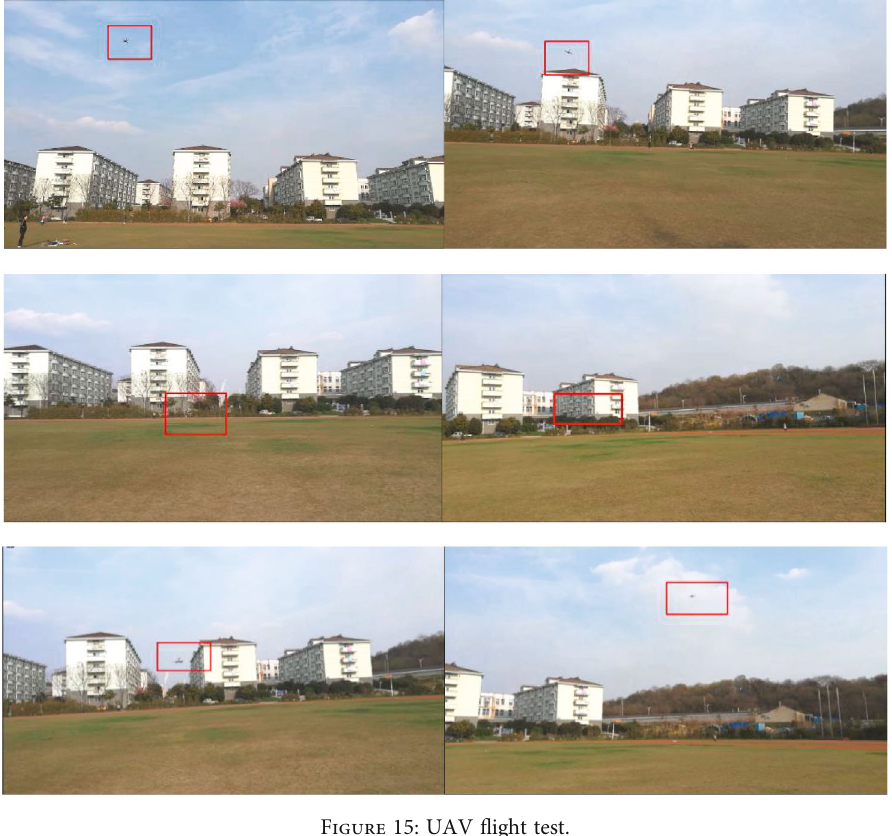
Figure 15: UAV fl ight test.